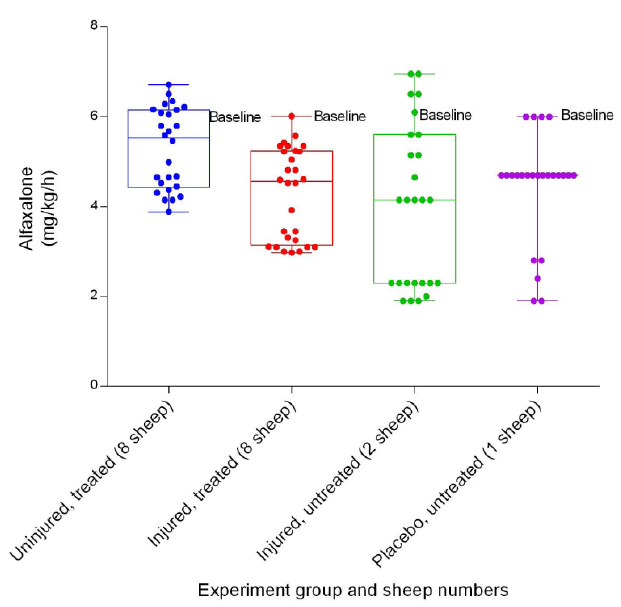
Figure 41. Alfaxalone infusion (Mean ± SD) indicating instantaneous hourly titration dose (represented by dots) in smoke and non-smoke injured sheep that received extracorporeal life support as compared to that in untreated controls over a 24 h period plus induction to the end of the experiments.